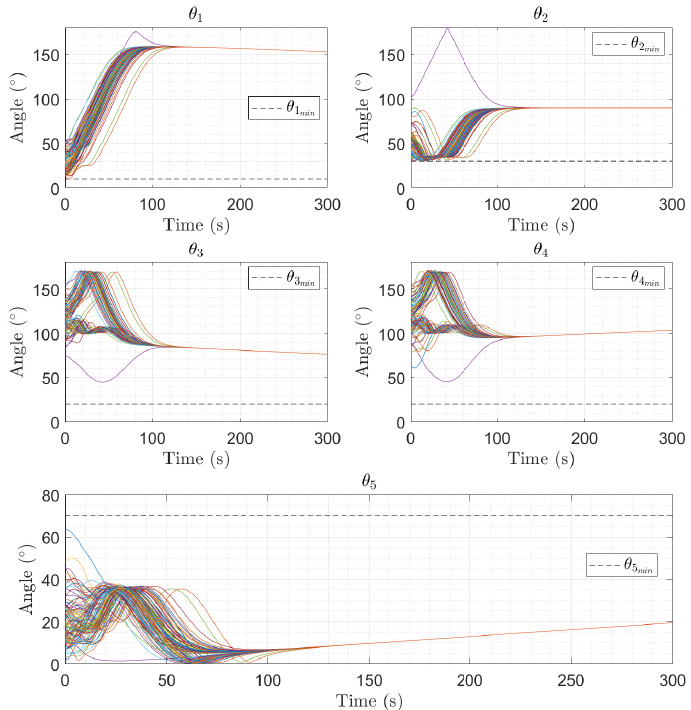
Figure 15. Angle progression of equipment with respect to the constraints. θ 1 to θ 4 represent the angle between Boresight 1 and the respective exclusion constraint, and θ 5 is the angle between Boresight 2 with respect to the inclusion constraint.